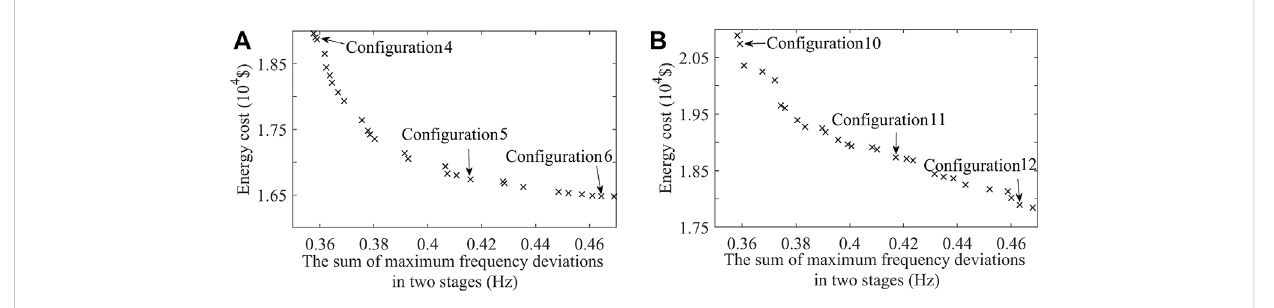
FIGURE 4 Pareto results without considering SFD under (A) scenario 1 and (B) scenario 2.